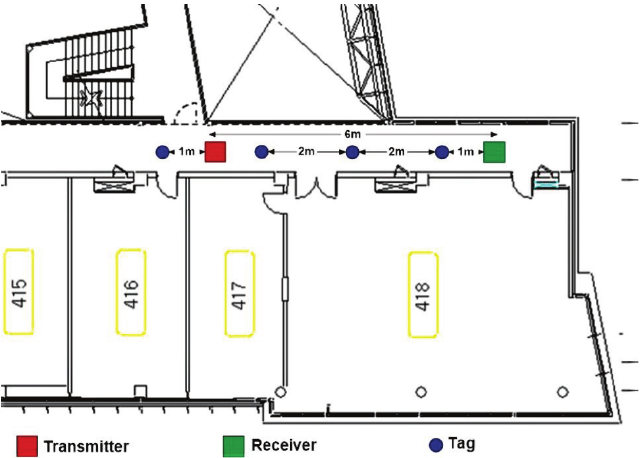
Figure 13. Hallway experimental